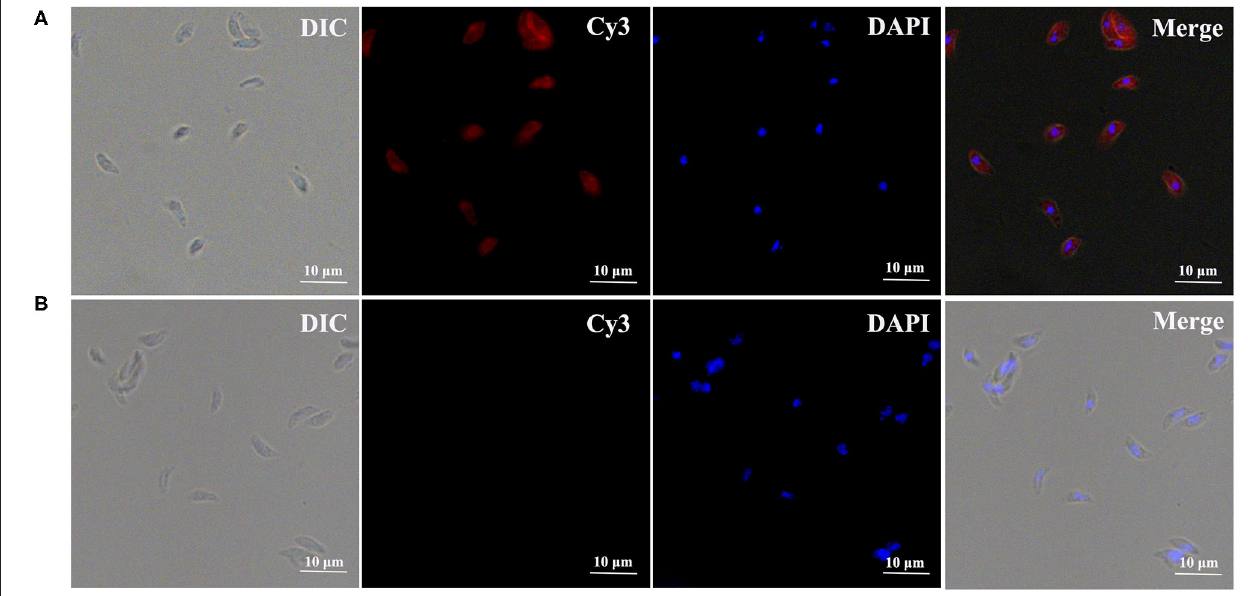
FIGURE 2 | Expression and distribution of TgPLP2 in T. gondii tachyzoites. DAPI-stained nuclei and Cy3-labeled TgPLP2 appeared blue and red, respectively. (A) Anti-rTgPLP2 PcAb was used as primary antibody. (B) As control, rat normal IgG was used as primary antibody.